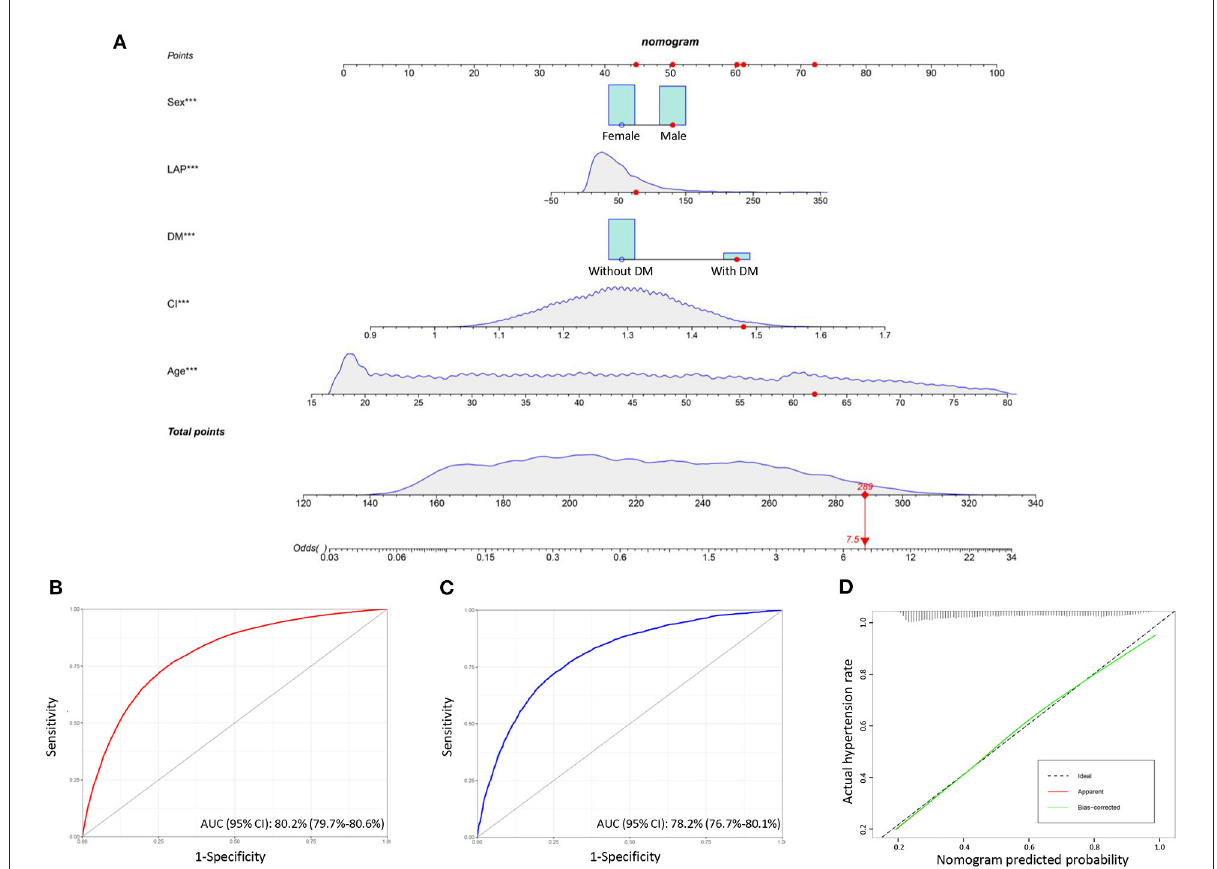
FIGURE5 Nomogram model for predicting hypertension risk. (A) Nomogram model shows the distribution of risk factors included, correspond to the points at the top, and the sum of the scores of all variables is total points. Red points show an example, for a 62 years-old with diabetes, a CI of 1.44 and a LAP of 76, the probability of hypertension increased by 7.5-fold; (B) ROC curve of the nomogram model in the training group; (C) ROC curve of the nomogram model in the validation group; (D) calibration curve of the nomogram model based on bootstrap validation with 1,000 re-samplings in the training